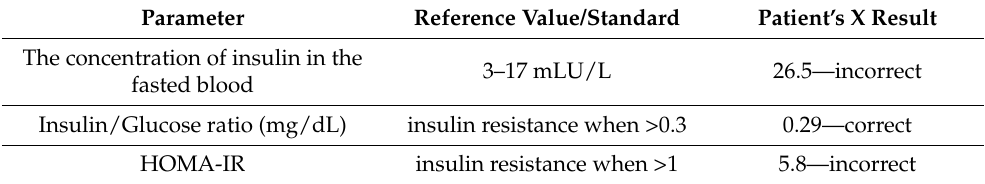
The concentration of insulin in